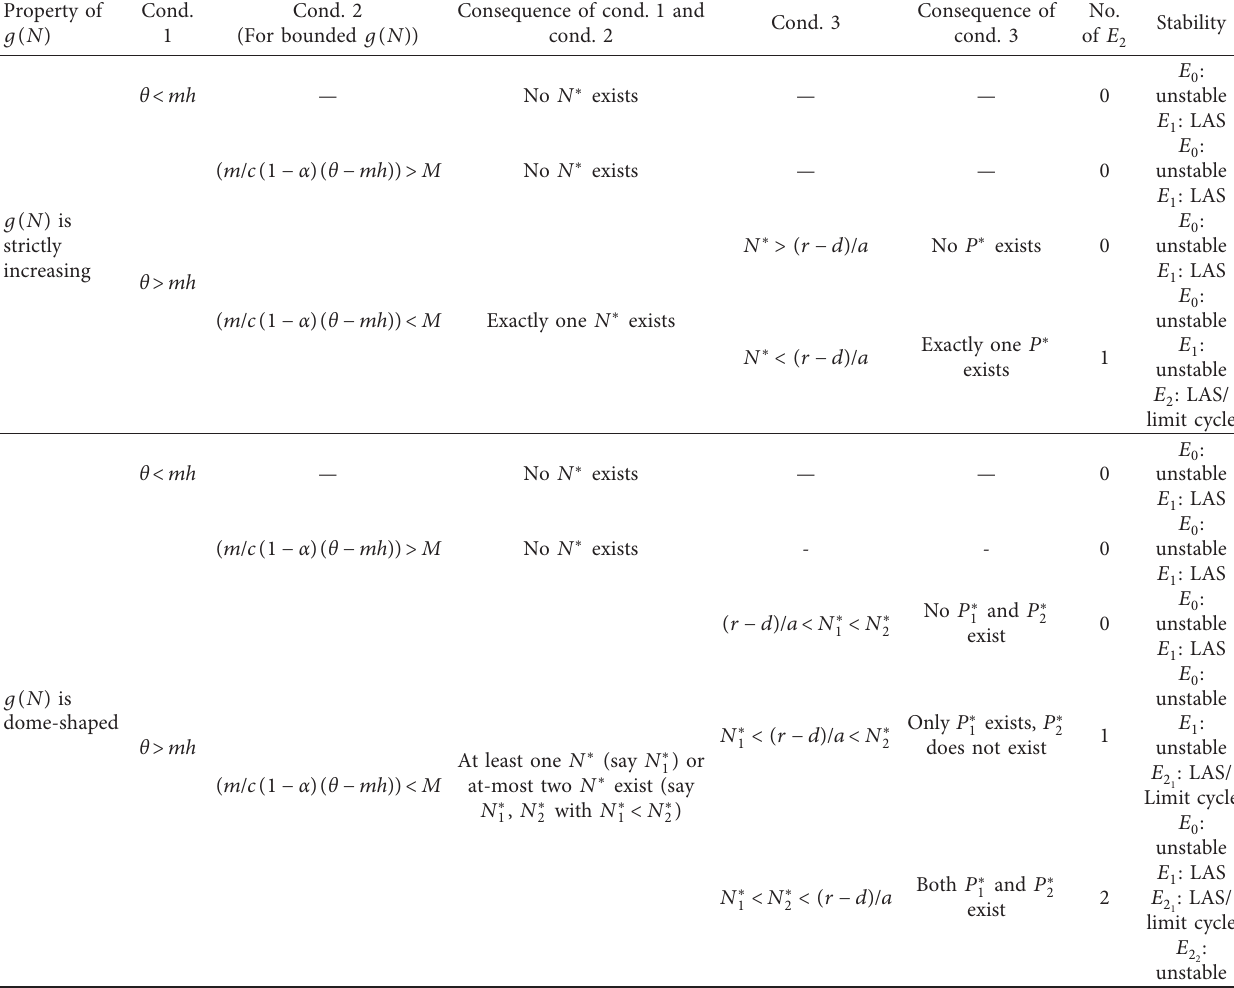
Table 1: Existence of steady states and their stability. Property of Cond. Cond. 2 Consequence of cond. 1 and g ( N ) 1 (For bounded g ( N ) ) cond.